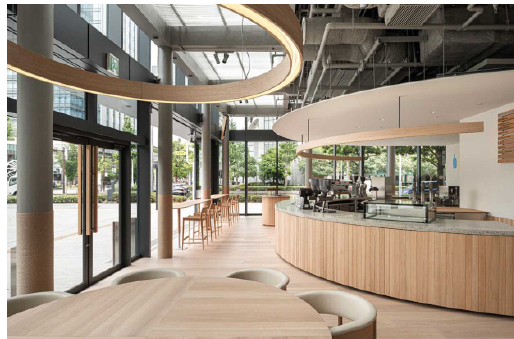
Figure 26. Blue Bottle in Yokohama [77].